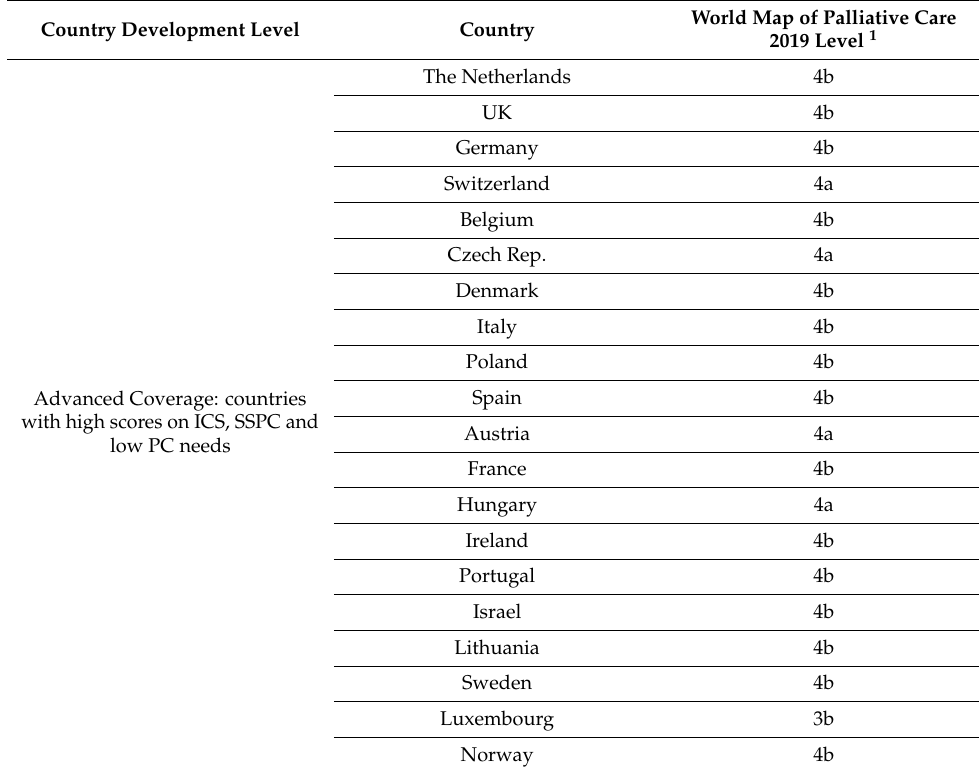
Table 3. Palliative care global development in European countries in comparison with the 2019 World Map